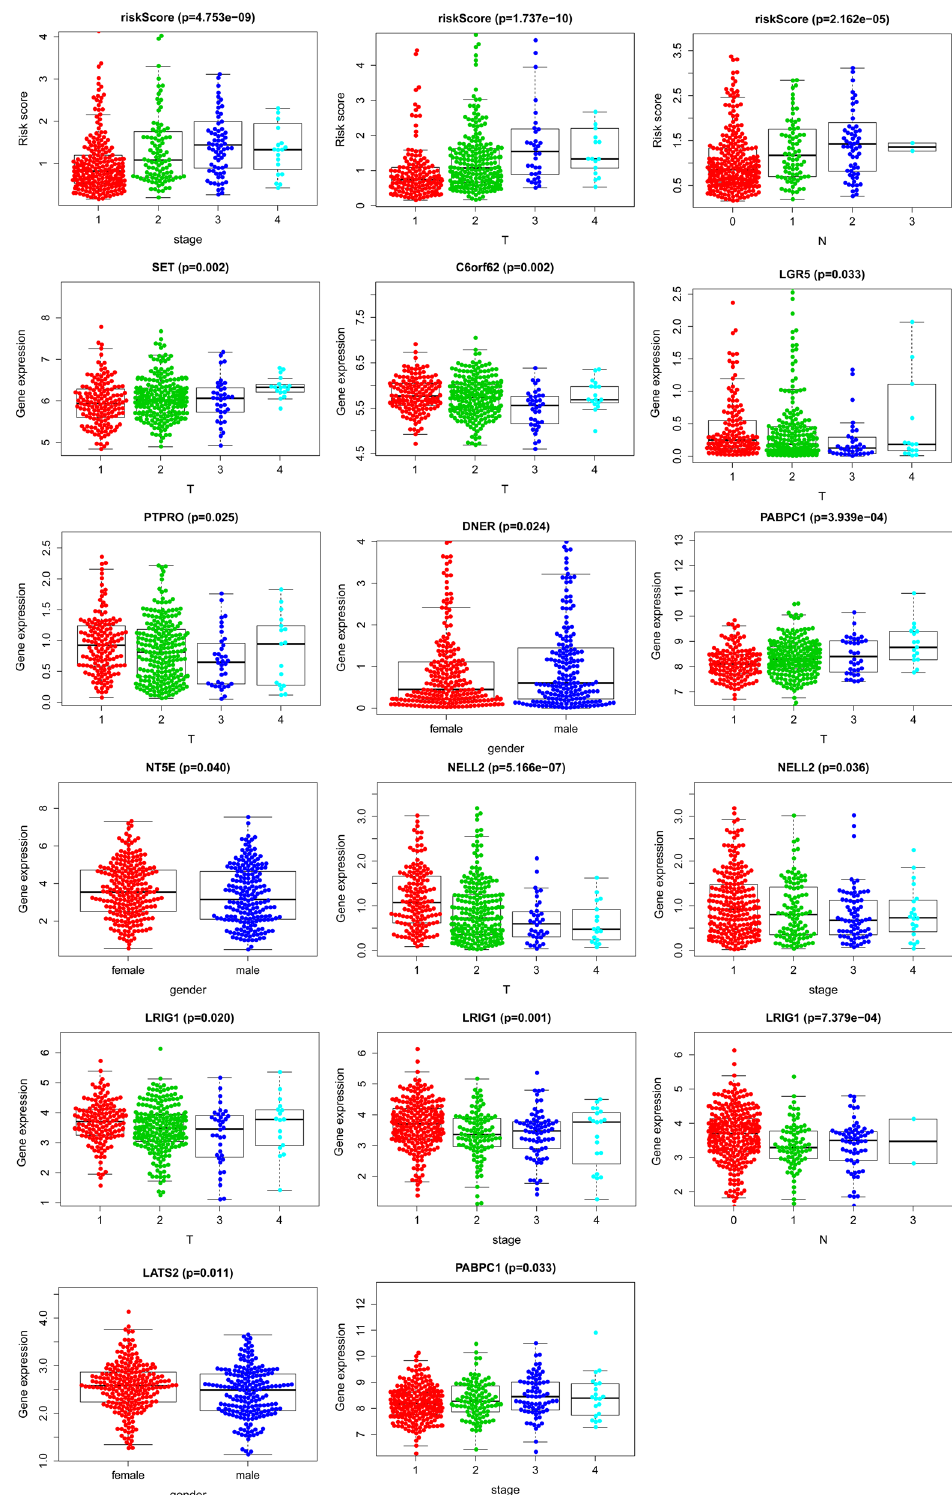
Figure 4. Subgroup analysis. The box plot showed the relationship among stem cell-related genes in the signature and each clinical